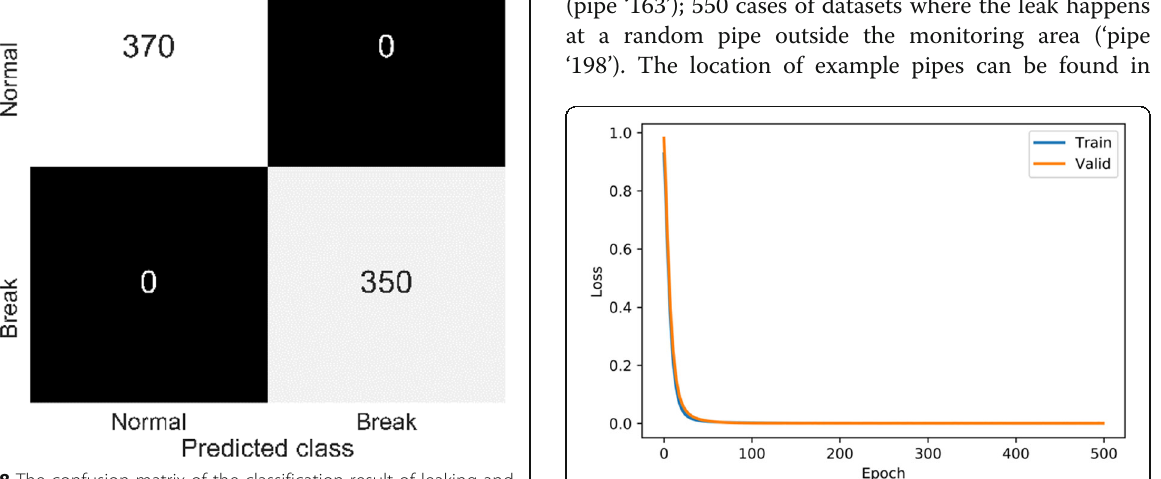
Fig. 9 Loss values (i.e., the reconstruction error) by the AE model during the training